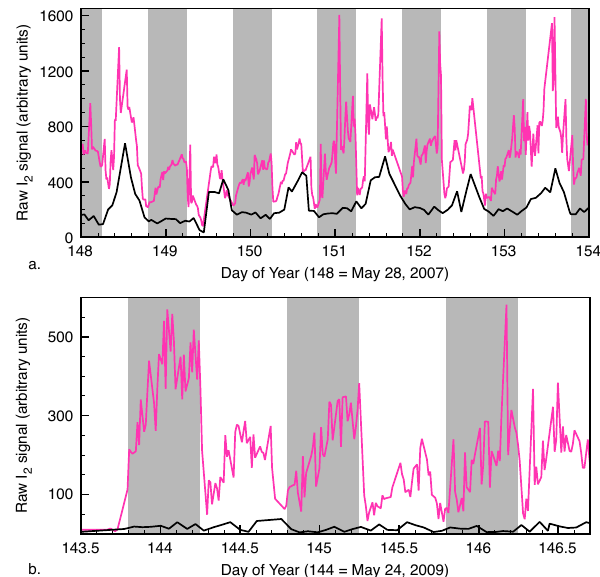
Fig. 4. Raw mass spectrometer I 2 signals from ambient air (ma- genta) and blank scrubbed air (black) during May 2007 (a) and May 2009 (b) . The correlation of daytime I 2 signals in ambient air signal and blank air during May 2007 is evidence that some of the daytime I 2 is an artifact that is likely produced on the inlet walls. In 2009, this correlation was not apparent, most likely due to a change in inlet configuration. Gray shaded areas are nighttime